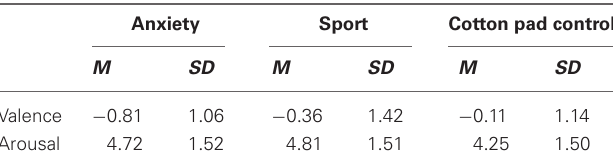
Table 4 | Valence and arousal ratings of the chemosensory stimuli in Experiment II